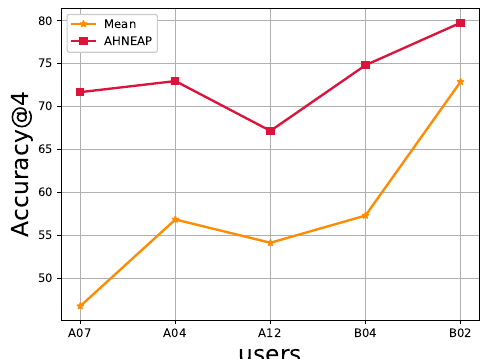
Figure 4. The comparison of prediction Accuracy @4 for the Mean and our framework AHNEAP with five users at interval of day scale.